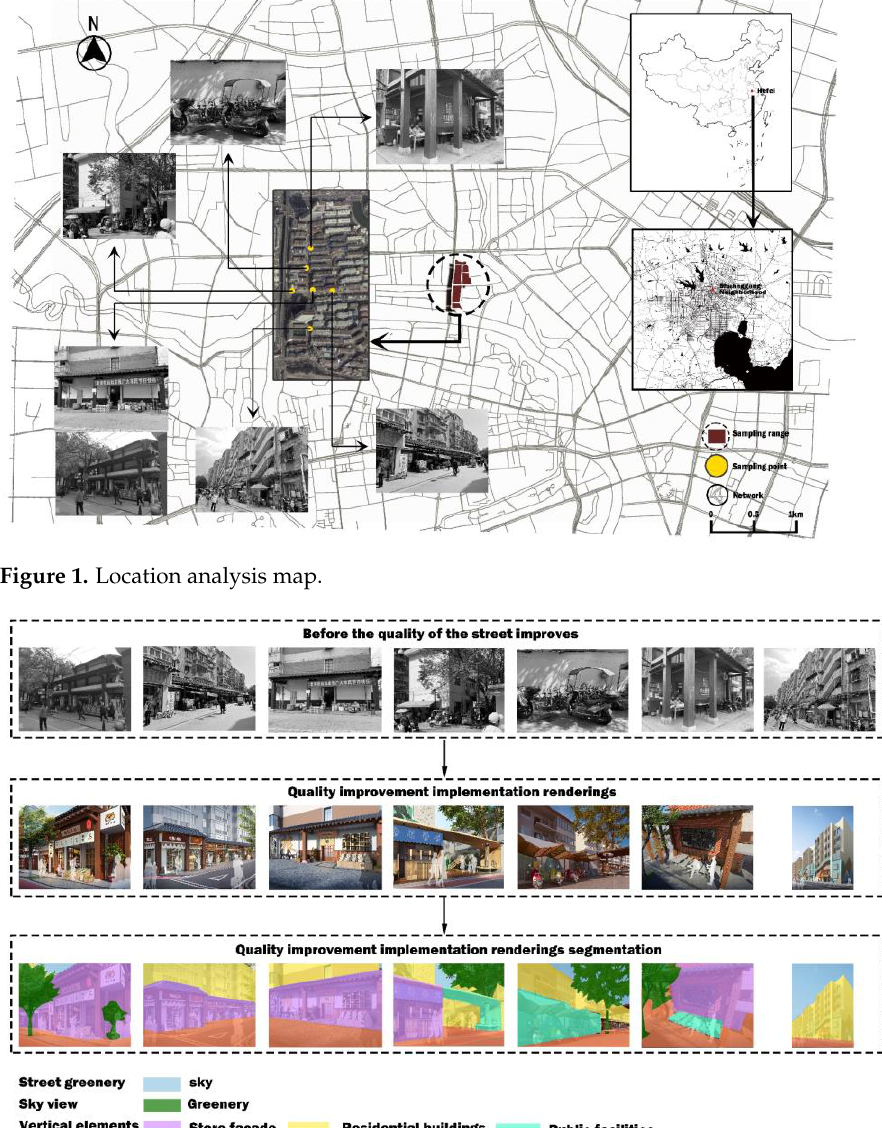
Figure 2. Quality enhancement